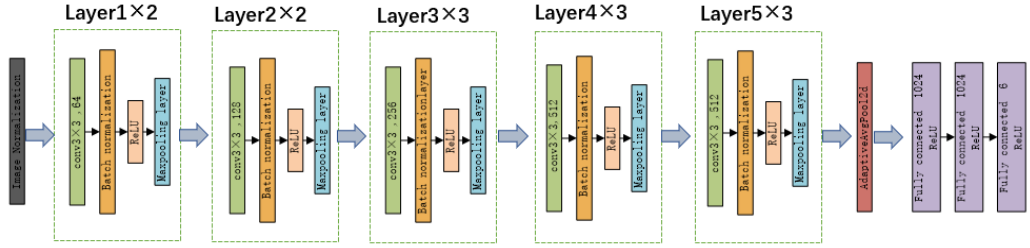
Figure 4. Green plum defect detection network structure.